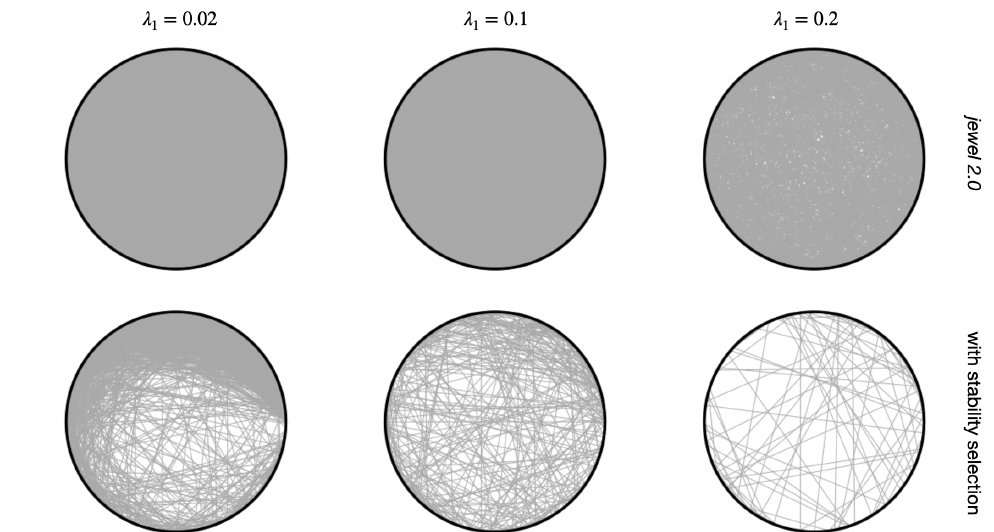
Figure 7. Estimated graph ˆ G ( 1 ) of one of the independent runs. Rows demonstrate results with jewel 2.0 and results with an additional stability selection procedure (# subsets = 25, choose edges present in 80% of results), columns correspond to different values of regularization parameter λ 1